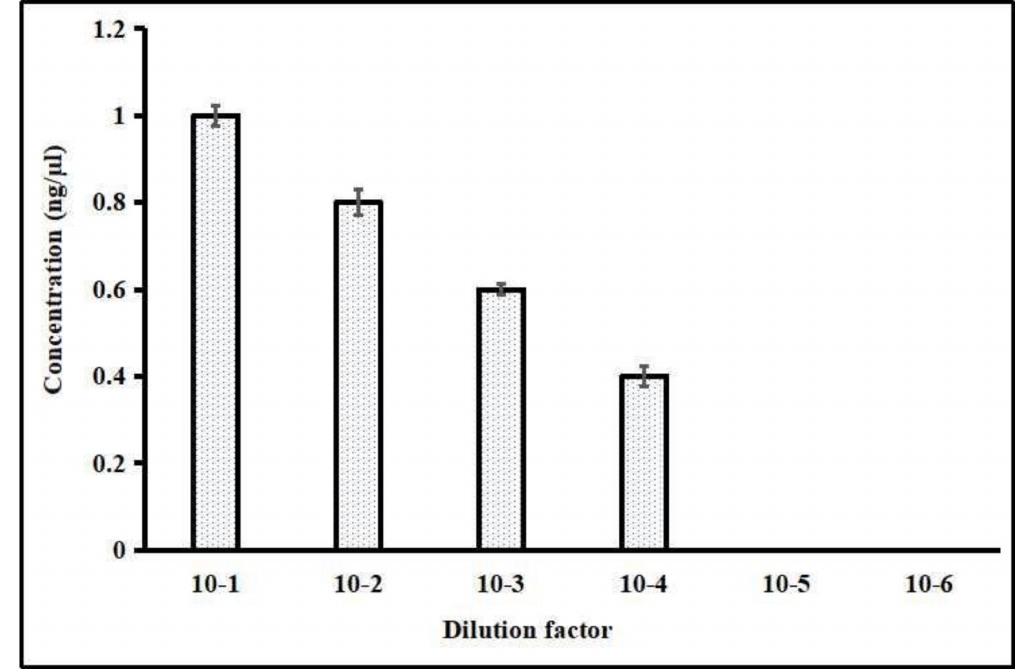
Figure 7. Graphical representation for sensitivity of LAMP. The lowest dilution limit of HNB–LAMP detection was up to 10 − 4 (7 parasites / µ